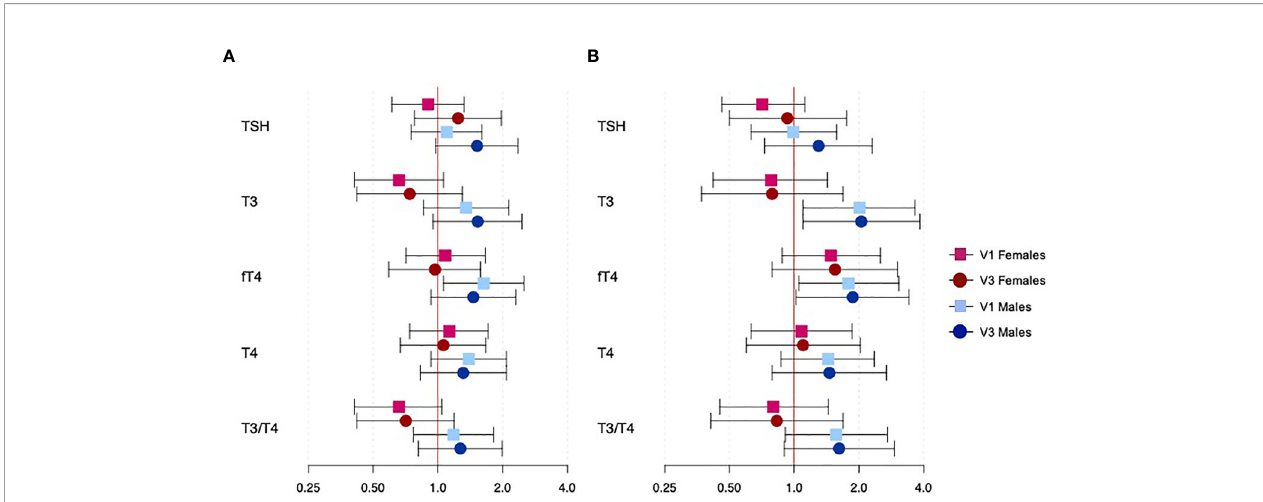
FIGURE 3 | Associations between thyroid hormone concentrations and binary outcomes of overall and spontaneous PTB, speci fi c to fetal sexes and study visit. Panel (A) shows overall PTB and panel (B) shows spontaneous PTB. Effect estimates represent the odds of overall or spontaneous PTB with an interquartile range increase in hormone concentration. Red and blue estimates correspond to female and male fetuses, respectively. Squares denote effects from hormones at visit 1, while circles denote effects from hormones at visit